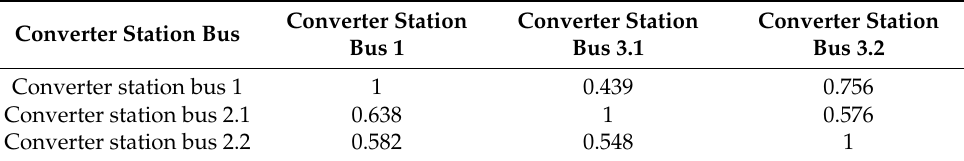
Table A6. The MIIF of converter station buses with Area 5 to be isolated.